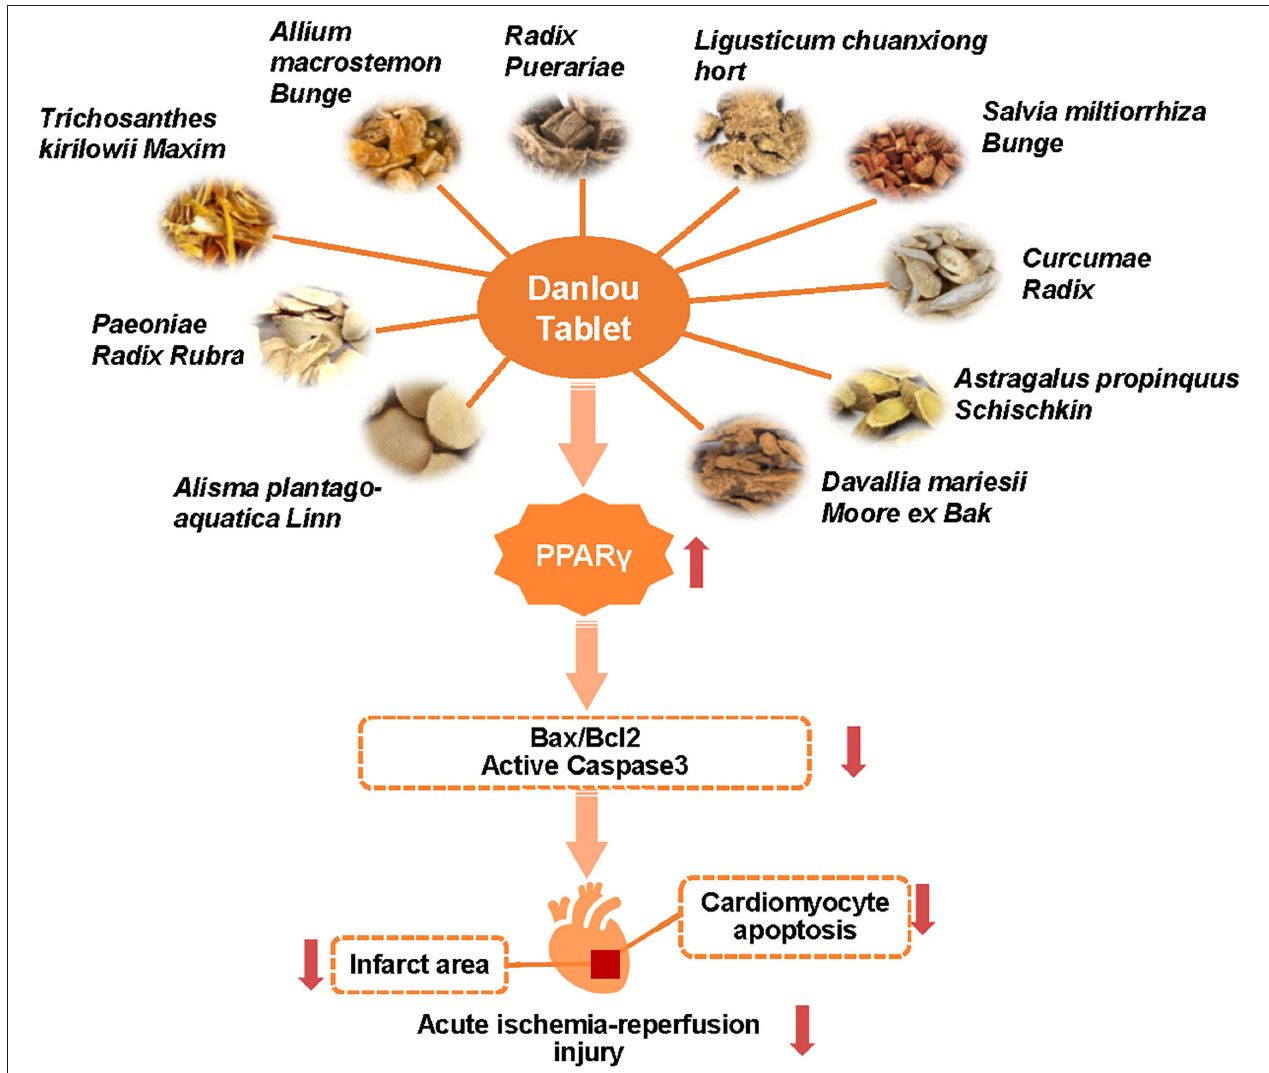
FIGURE 5 | Danlou tablet protects against acute myocardial ischemia-reperfusion injury and reduces CM apoptosis through activating PPAR γ